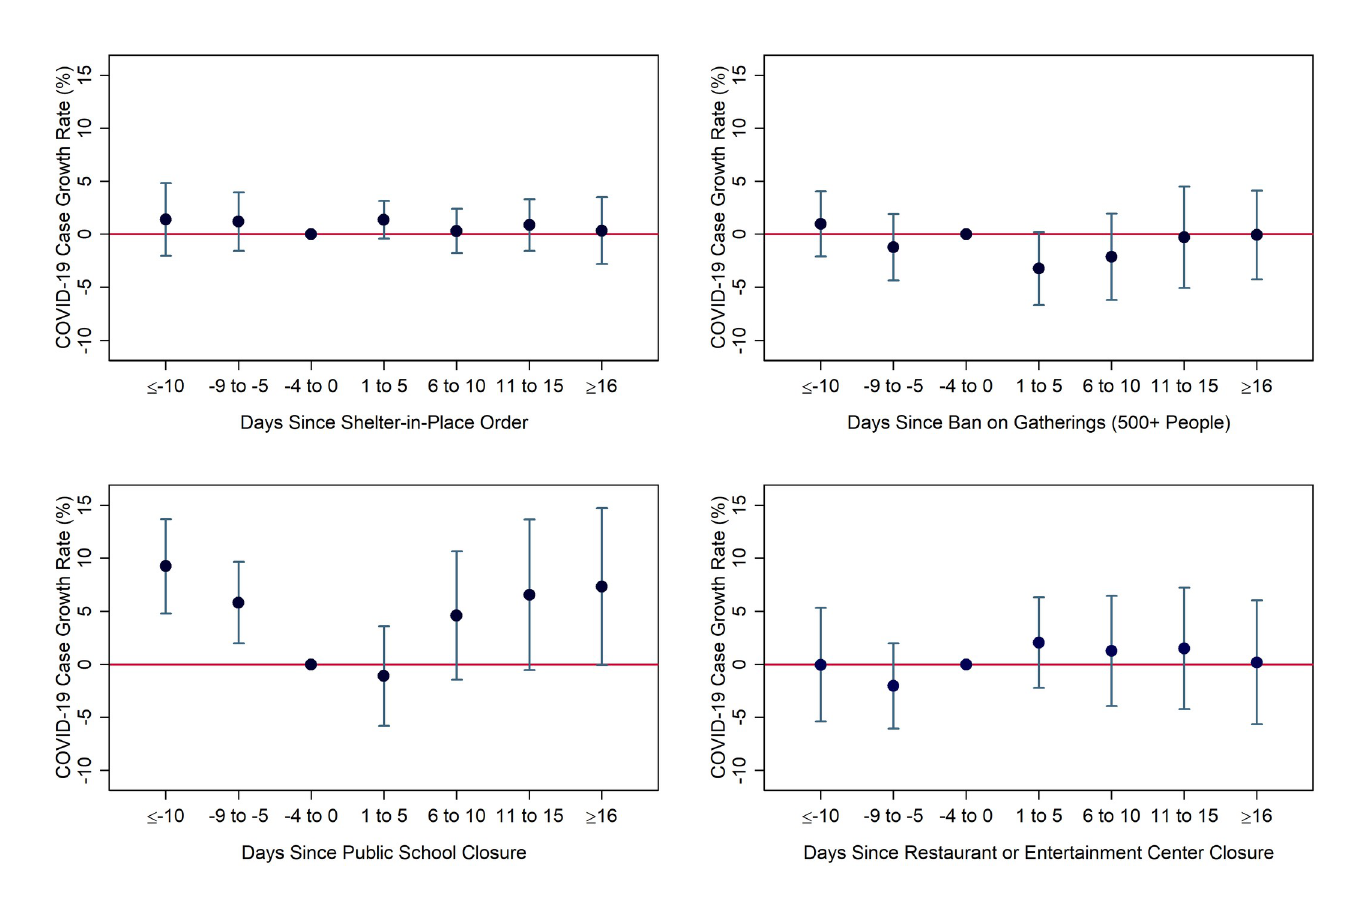
Fig 6. Predicted effects of social-distancing measures in Kentucky outside of Louisville and Lexington. Notes: Coefficients and 95% confidence intervals were derived from authors’ event-study regression using daily county-level data from March 5-April 25 from the South and Midwest Census Regions, weighted by population. Day and county fixed effects were included. Standard errors were heteroskedasticity-robust and clustered by state. Specifications include interactions between regulations indicators and the “white working-class” index variable. Results shown are linear combinations of uninteracted and interacted policy variables, evaluated at the average index value of 1.34 in Kentucky (excluding Lexington and